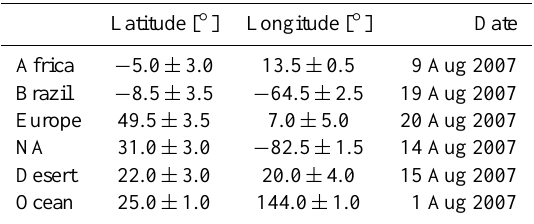
Table 1. Regions selected for Fig.